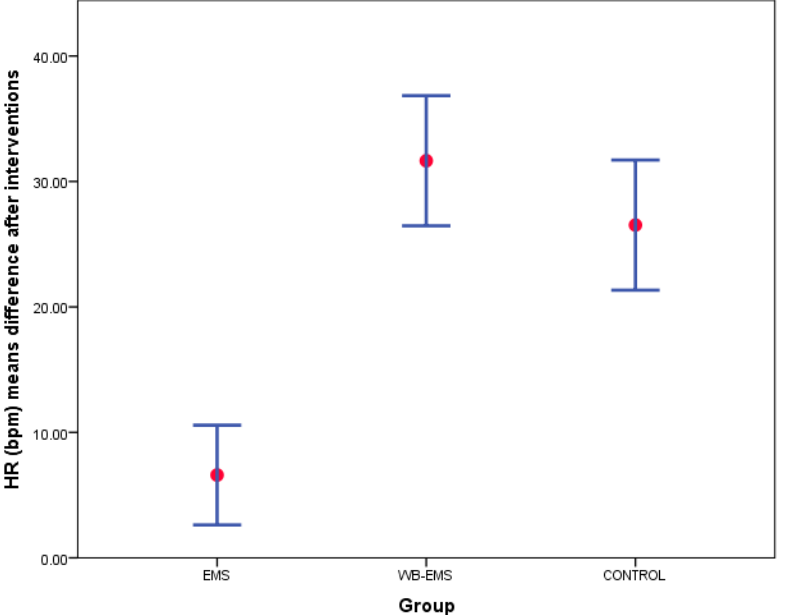
Figure 7. Bar graphs showing HR mean differences after interventions completed with SD among the EMS, WB-EMS, and control groups. Abbreviations: bpm, beats per minute; EMS, electrical muscle stimulation; SD, standard deviations; WB-EMS, whole body electrical muscle stimulation.